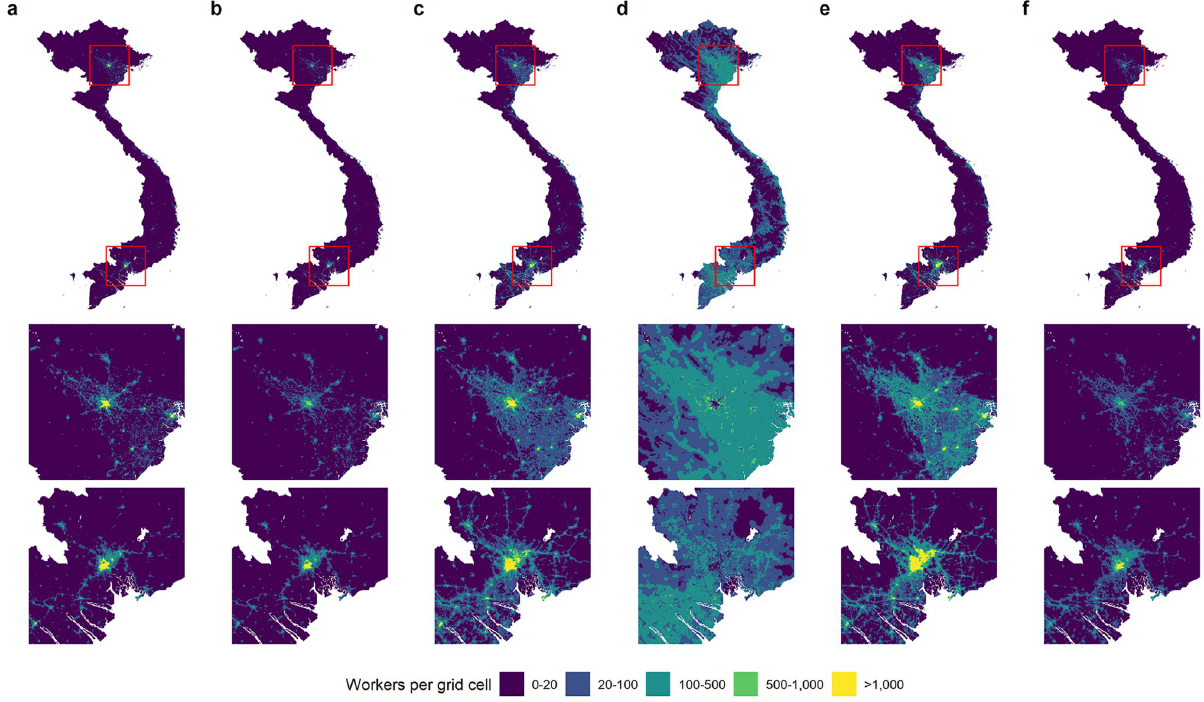
Fig 2. Spatial predictions for the number of (a) Managers and professionals, (b) Technicians and associate professionals, (c) Clerks and service workers, (d) Agricultural workers, (e) Craft workers and operators and (f) Elementary occupations per grid cell. Bottom panels depict the spatial distribution of the number of workers around Hanoi and Ho Chi Minh City, respectively. An interactive version can be accessed at https://shiny.wur. nl/occupation-map-vnm.